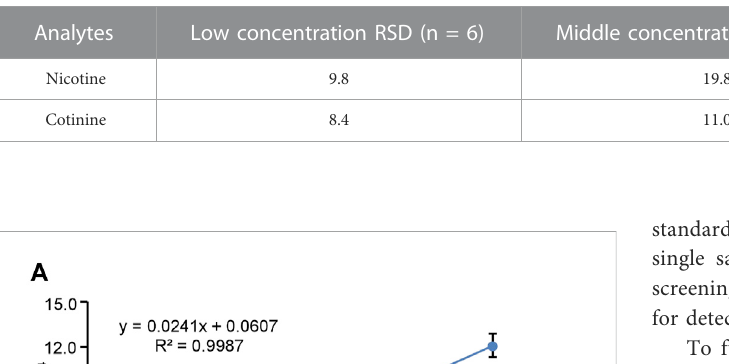
TABLE 2 RSDs (n = 6) of nicotine and